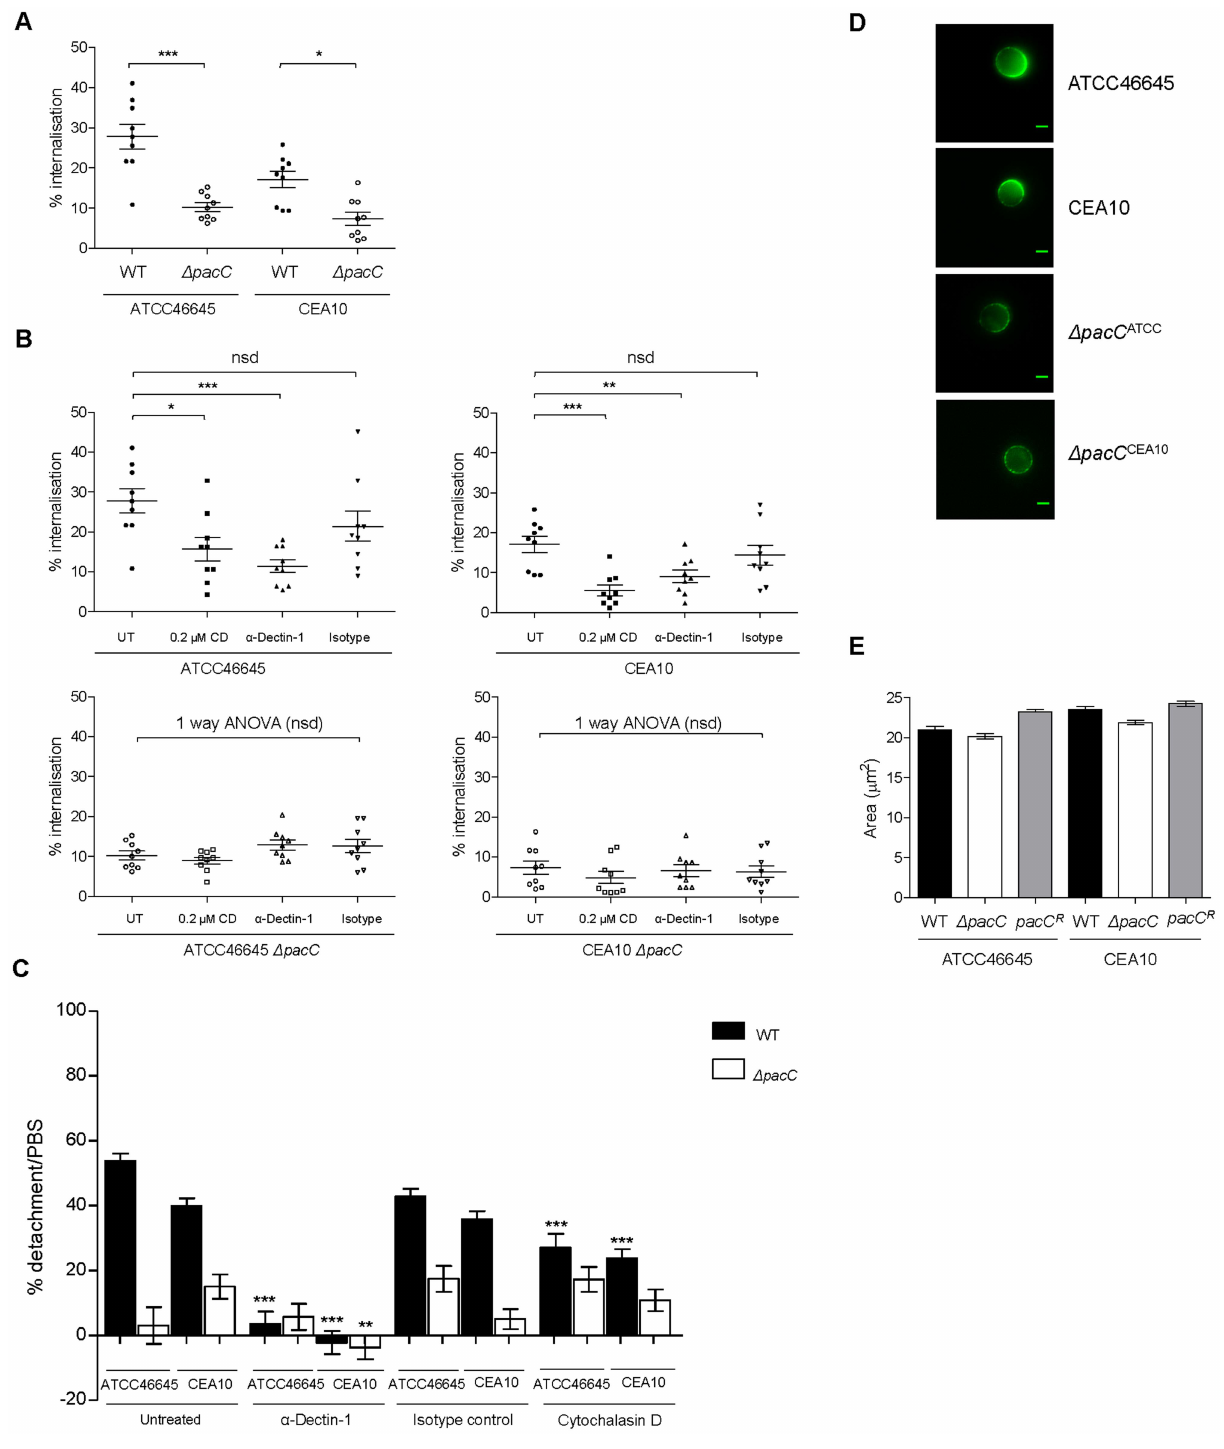
Figure 6. D pacC mutants are less avidly internalised by A549 and spore internalisation depends on Dectin-1. (A) Percent internalisation by nystatin protection assay. Epithelial monolayers were incubated with 10 6 spores/ml for 4 hr, n = 9 for wild types and D pacC . (B) Percent internalisation, when blocking the Dectin-1 receptor (0.3 m g/ml a -Dectin-1 antibody) or actin-mediated internalisation (0.2 m M CD), or in the presence of an isotype control antibody (0.3 m g/ml) technical and biological duplicates. (C) Percent detachment, relative to PBS challenge, of A549 upon infection with A. fumigatus (10 5 spores/ml) for 16 hr and inhibition of actin-mediated internalisation via Cytochalasin D (CD, 0.2 m M), when blocking the Dectin-1 receptor (0.3 m g/ml a -Dectin-1 antibody) or in the presence of an isotype control antibody (0.3 m g/ml), technical and biological triplicates. (D) Use of a soluble Fc Dectin-1 protein for immunofluorescence-mediated imaging of b -glucan in A. fumigatus spores, 4 hr, supplemented DMEM. (E) A. fumigatus spore size ( m M 2 ), 4 hr, supplemented DMEM. A, B, C: unpaired t test (unless otherwise indicated) *** p , 0.001, ** 0.001 , p , 0.01, and * 0.01 , p , 0.05.